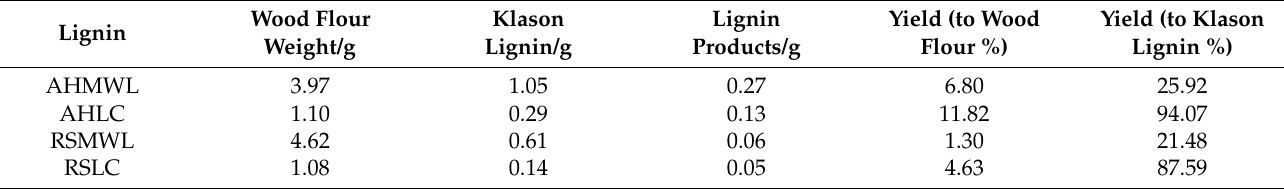
Table 3. Yield of MWL and LC of two raw